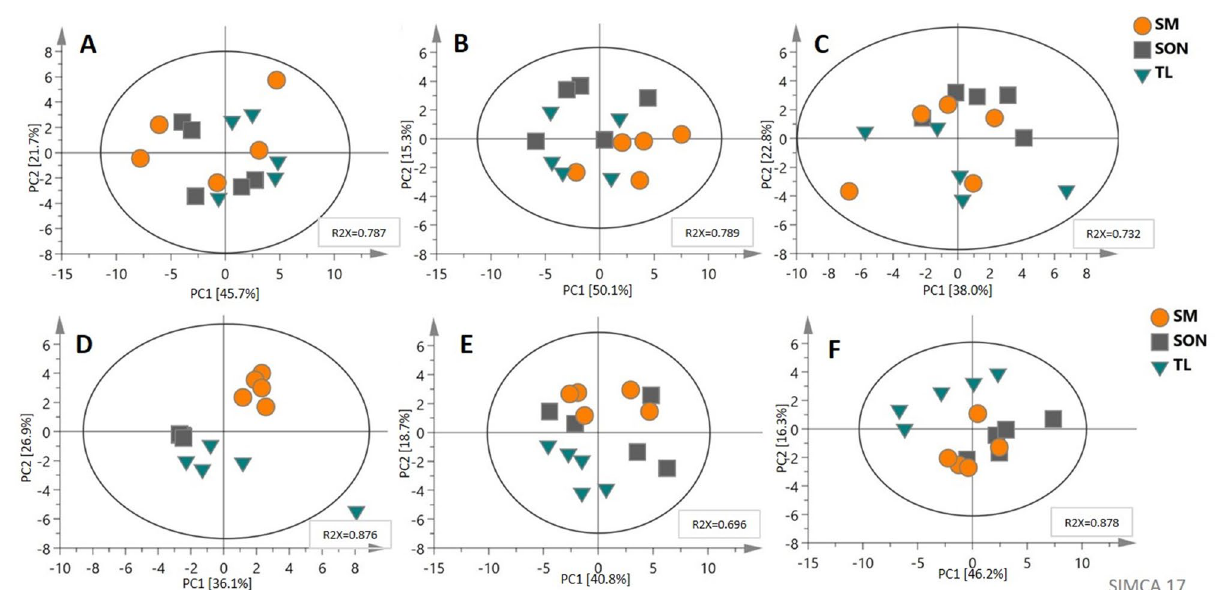
Figure 5. PCA models for separate analysis of each single bacterium strain. ( A ) B. cereus ; ( B ) E. feacalis ; ( C ) C. glutamicum ; ( D ) E. coli ; ( E ) K. pneumoniae ; ( F ) P. aeruginosa (SM—sand mill; SON—sonication; TL—tissue